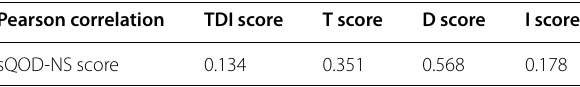
(refer to Table 3: statistical comparison using preopera- tive and postoperative non-parametric test using Wil- coxon signed-rank test for taste).